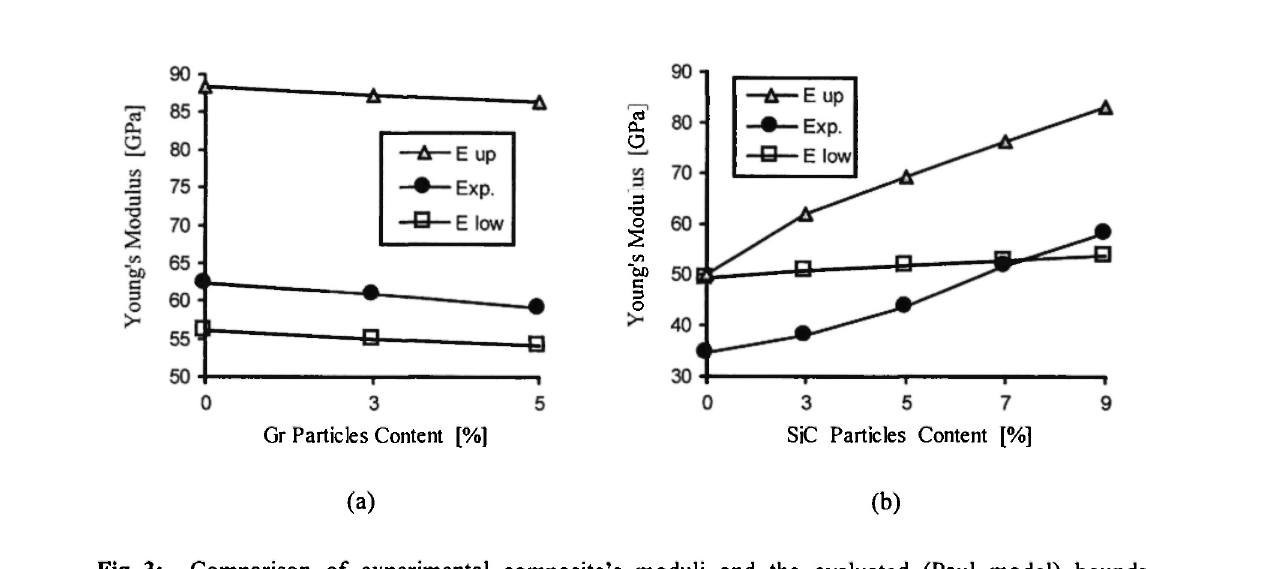
Fig. 3: Comparison of experimental composite's moduli and the evaluated (Paul model) bounds (a) 10% SiC and a variable content of Gr particles; (b) 5% Gr and a variable content of SiC